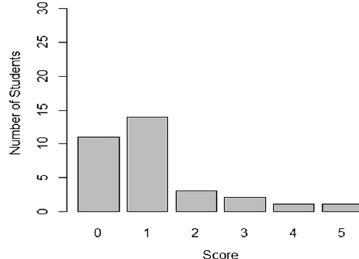
Fig. 10 Distribution of the scores in Screen 7